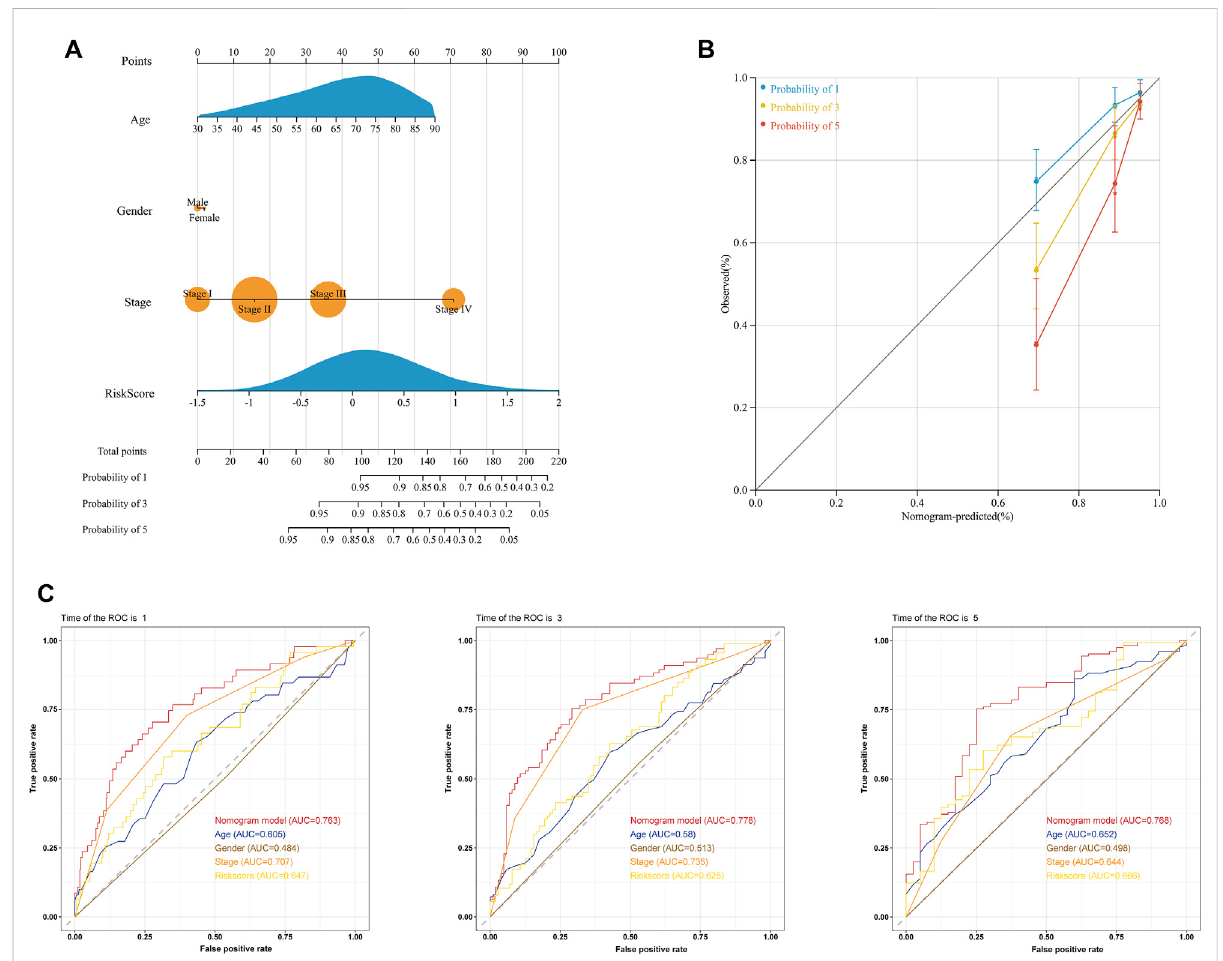
FIGURE 6 PredictionoftheOS of COAD patients using aclinical nomogram. (A) Nomogram for predicting the1-, 3-, and 5-year OS of COAD patients. (B) Calibrationcurvesofthenomogram forpredictingOSat1,3,and5 years. Nomogram-predictedsurvivalisontheX-axis,andactualsurvivalisonthe Y-axis. (C) ROC curves of the nomogram for predicting the 1-, 3- and 5-year OS.